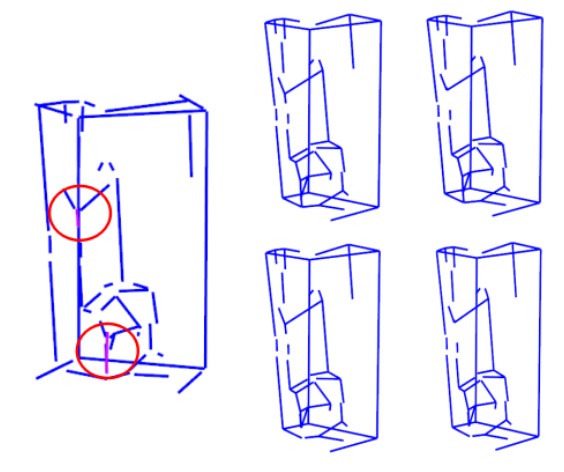
Figure 6. Some basic models generated due to the corner selection. Collision areas are shown in the red area on the